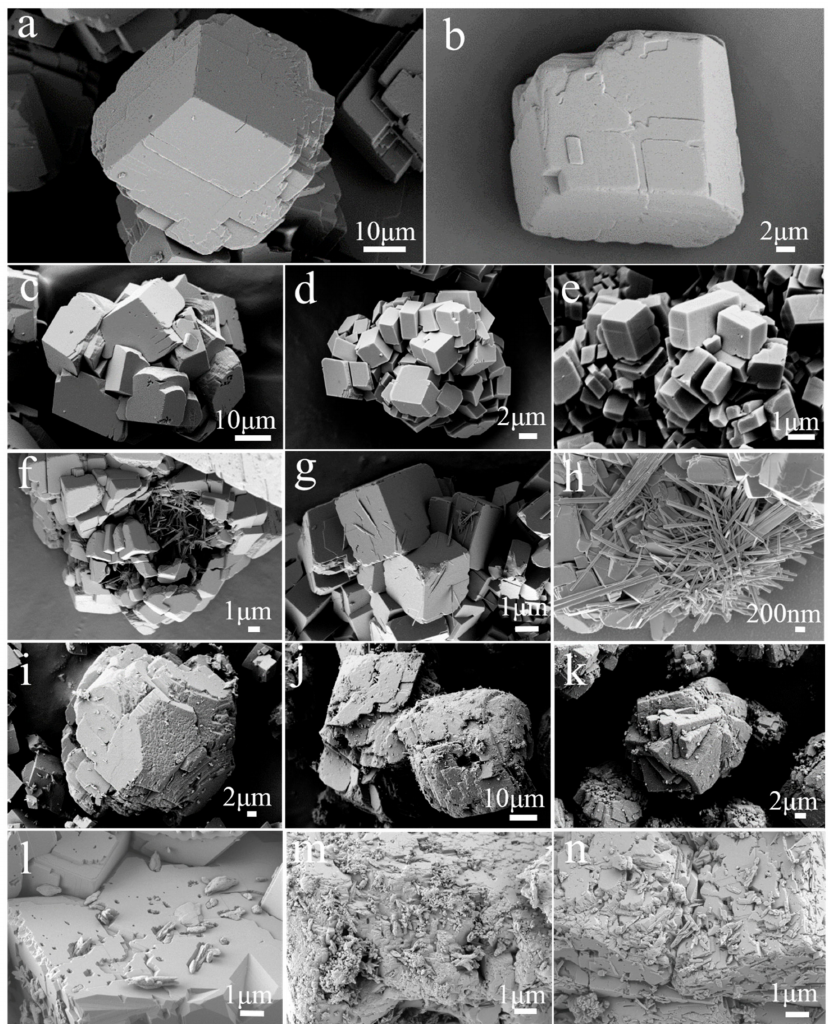
Figure 3. Scanning electron microscope (SEM) images of the synthetic calcite solid solutions. ( a ) CAL; ( b ) CAL after dissolution for 2880 h; ( c ) Mn-02; ( d ) Mn-04; ( e ) Mn-10; and ( f ) Mn-02 after dissolution for 1920 h; ( g ) Mn-04 after dissolution for 672 h; ( h ) Mn-10 after dissolution for 1920 h; ( i ) Cu-02; ( j ) Cu-04; ( k ) Cu-10; and ( l ) Cu-02 after dissolution for 960 h; ( m ) Cu-04 after dissolution for 672 h; ( n ) Cu-10 after dissolution for 960